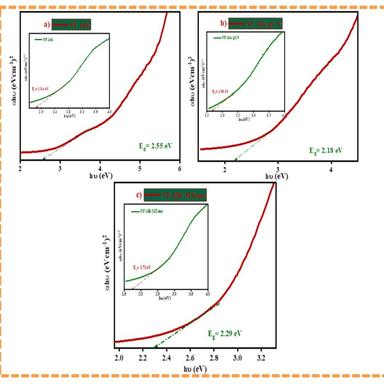
Direct and Indirect bandgap calculation of NF-ldh, NF-ldh/gCN, and NF-ldh/MXene by the Tauc plots.